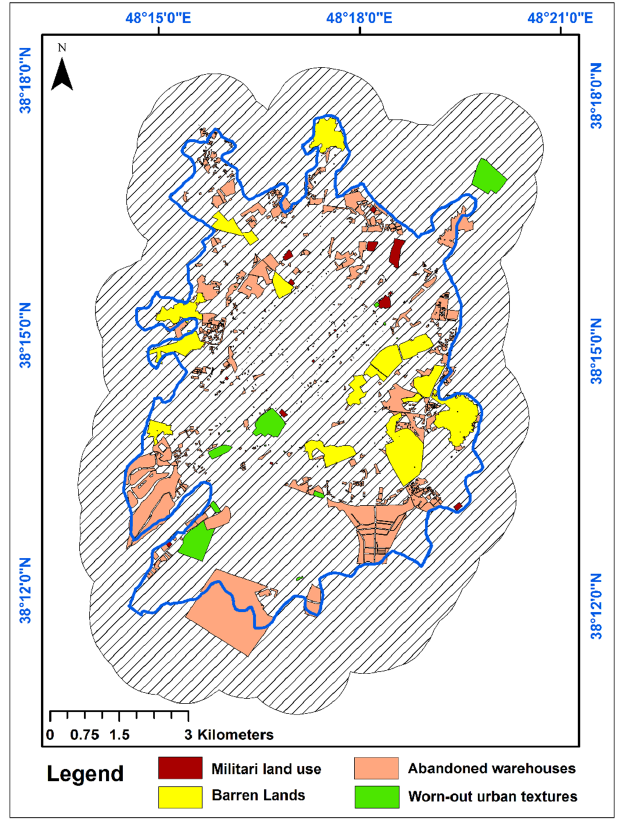
Figure 8. Distribution of potential infill development land uses in Ardabil city. Due to rapid urbanization, small villages, military sites, and industrial areas that used to be outside the city are gradually surrounded by built-up areas and absorbed by the rapidly growing city. The area of all land uses is shown in Table 6. Table 6. The calculated brownfield sites that have the potential to be used as infill development. Infill Development Potential Area (ha) Area (%) Land Demand (2030) Military land use 118.8